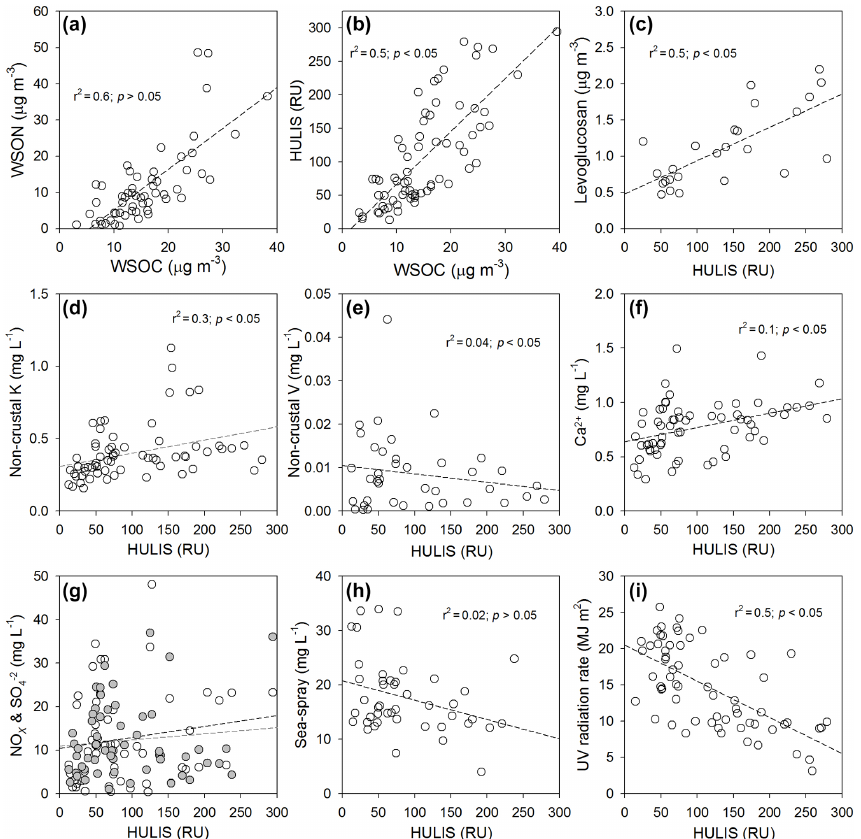
Figure 3. Plots of the concentrations of (a) WSOC versus WSON, (b) WSOC versus HULIS, (c) HULIS versus levoglucosan, (d) HULIS versus non-crustal K, (e) HULIS versus non-crustal V, (f) HULIS versus Ca 2 + , (g) HULIS versus NO x (closed circle; r 2 = 0 . 1, p> 0 . 05) and SO 2 − (open circle; r 2 = 0 . 02, p< 0 . 05), (h) HULIS versus sea spray, and (i) HULIS versus UV radiation rate. The dashed lines represent 4 the regression